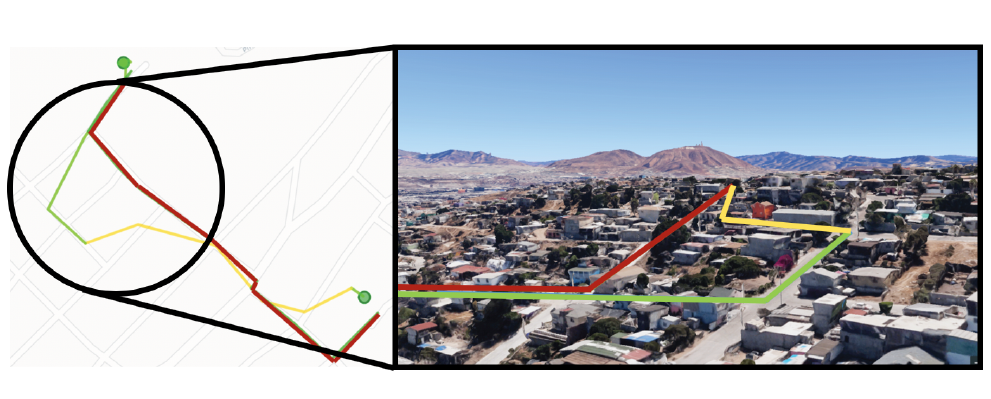
Figure 5. Differences between the expected route, as suggested by Google Maps, and the actual route taken by the neighbors. It can be seen (left) that sometimes the actual route is longer than the suggested one; but in those cases, it is less steep (right) and thus easier to take while walking.